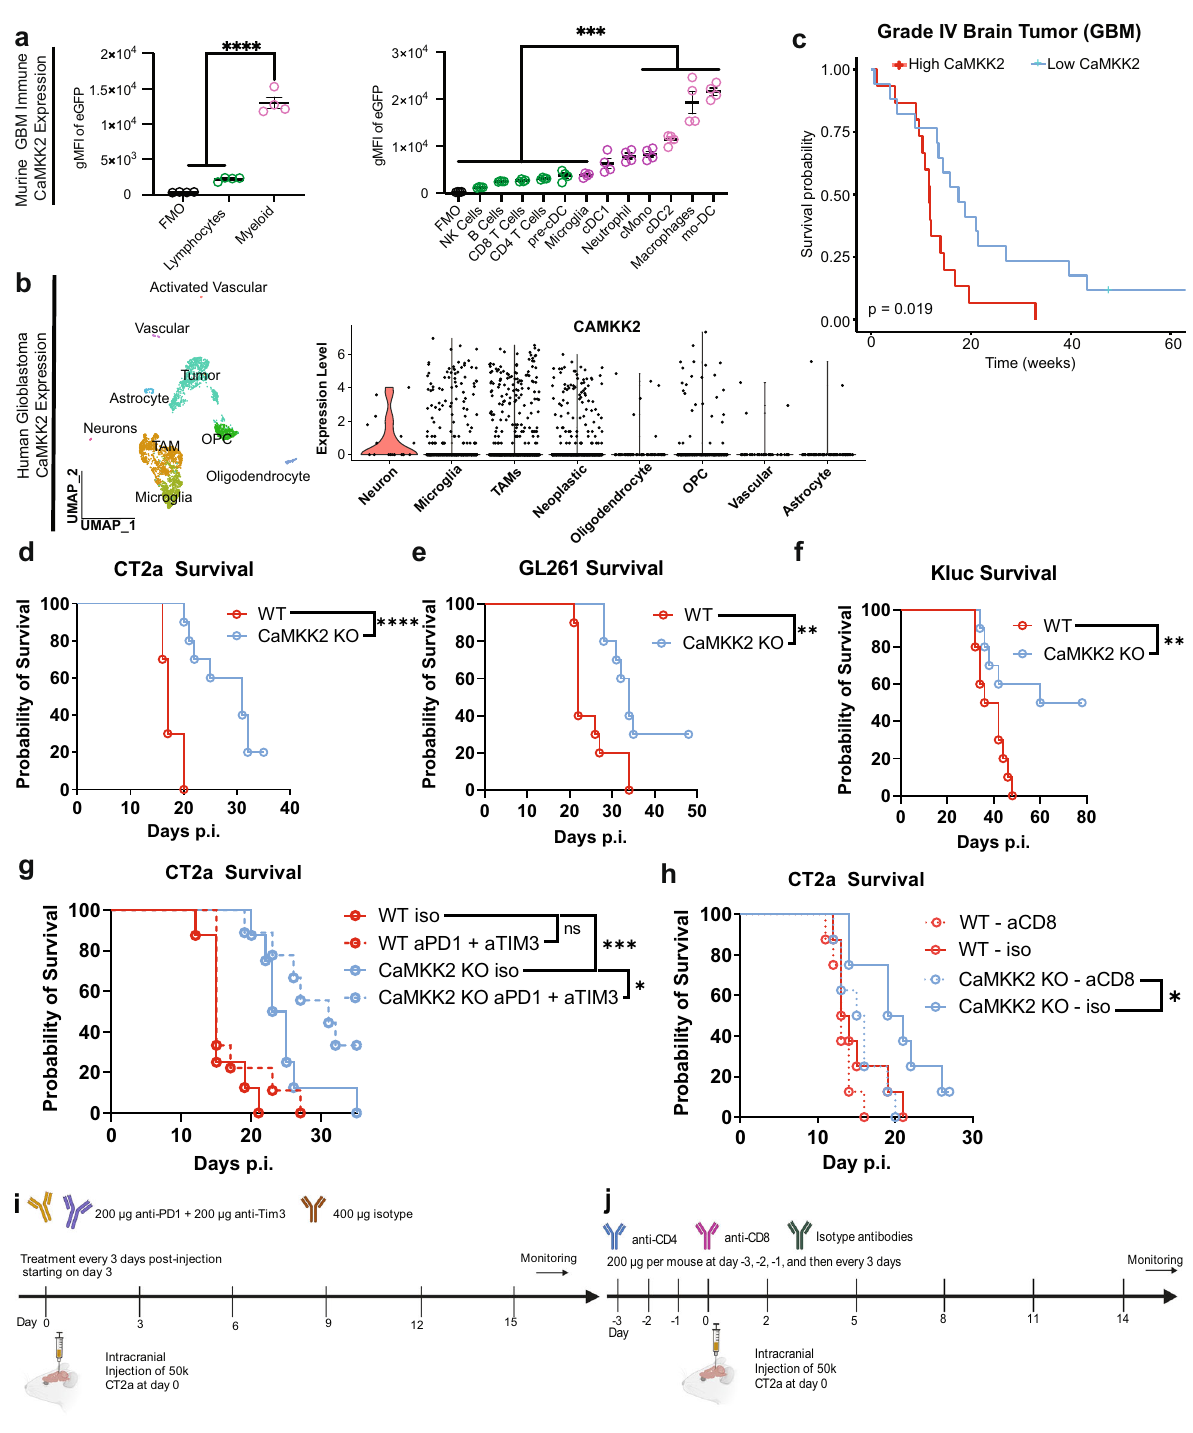
Fig. 1 | CaMKK2 expression within the GBM TME is associated with poor sur- vival and resistance to ICB. a Tumor-bearing hemispheres were harvested from WT (FMO) or CaMKK2-EGFP mice on D14 and stained with a multi-color fl ow panel to resolve major immune populations. n =4 mice per genotype, one-way ANOVA p <0.05 with unadjusted post hoc two-tail Fisher LSD t -test. Data are presented as mean ± SEM. **** p <0.0001, *** p =0.0004. b UMAP plot of Human Glioblastoma tumormicroenvironment, and Violinplot of CaMKK2expression in corresponding cell types. Data pulled from http://gbmseq.org/ and re-analyzed. c Glioblastoma survival strati fi ed by median Log2(CaMKK2) expression where above median expression was considered “ High ” and below “ Low ” . High n =15, low n =17, Log- ranktest. d – f Micewereintracraniallyimplantedwith50kCT2a,100kGL261,or50k